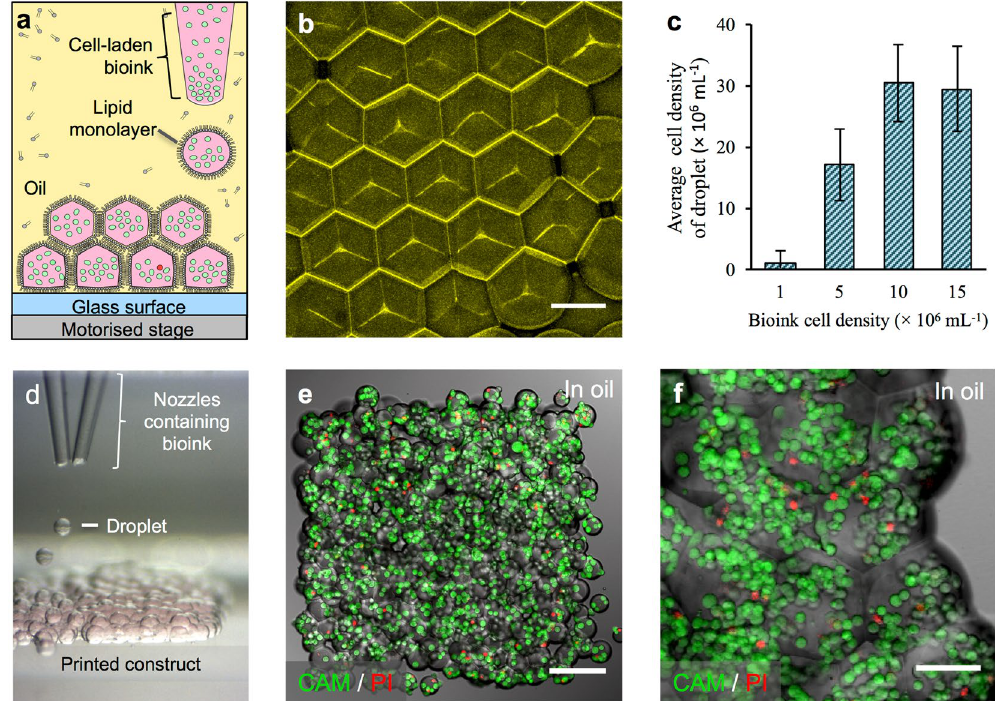
Figure 1. 3D printing of cellular constructs. ( a ) Schematic of cell printing. The dispensing nozzle ejects cell-containing bioink droplets into a lipid-containing oil. The droplets are positioned by the programmed movement of the oil container. The droplets cohere through the formation of droplet interface lipid bilayers. ( b ) A confocal fluorescence micrograph showing droplet interface bilayers (stained yellow) within a cell-free printed construct (11 × 14 × 7 droplets). The bilayers were visualised by adding sulforhodamine-101 (~10 μ M) to the print solution. (Scale bar = 100 μ m). ( c ) Histogram showing the mean HEK-293T cell density in printed droplets under oil as a function of the cell density in the bioink. The cell density was calculated as the mean number of cells per droplet ( n = 25) divided by the mean droplet volume. Error bars represent the compound error of droplet size variance and cell per droplet variance. ( d ) A bright-field micrograph of a patterned cell junction, containing two cell types, printed as successive layers of 1 nL droplets ( d = 130 μ m) ejected from two glass nozzles ( d = ~150 μ m). ( e ) A confocal fluorescence micrograph of a printed HEK-293T cellular construct (11 × 14 × 2 droplets) under oil. Live/dead cell staining was performed with calcein-AM (CAM, green) and propidium iodide (PI, red), respectively. Visible are approximately 700 cells at 4 × 10 7 cells mL − 1 with a viability of 85% (determined by manual cell counting). (Scale bar = 150 μ m). ( f ) A high magnification, confocal fluorescence micrograph of a live/dead assay performed on an HEK-293T cellular construct (7 × 8 × 4 droplets) printed at a starting concentration of 1.5 × 10 7 cells mL − 1 , with a mean occupancy of 38 cells per droplet equivalent to 3 × 10 7 cells mL − 1 . Visible are some of the droplet boundaries. (Scale bar = 75 μ